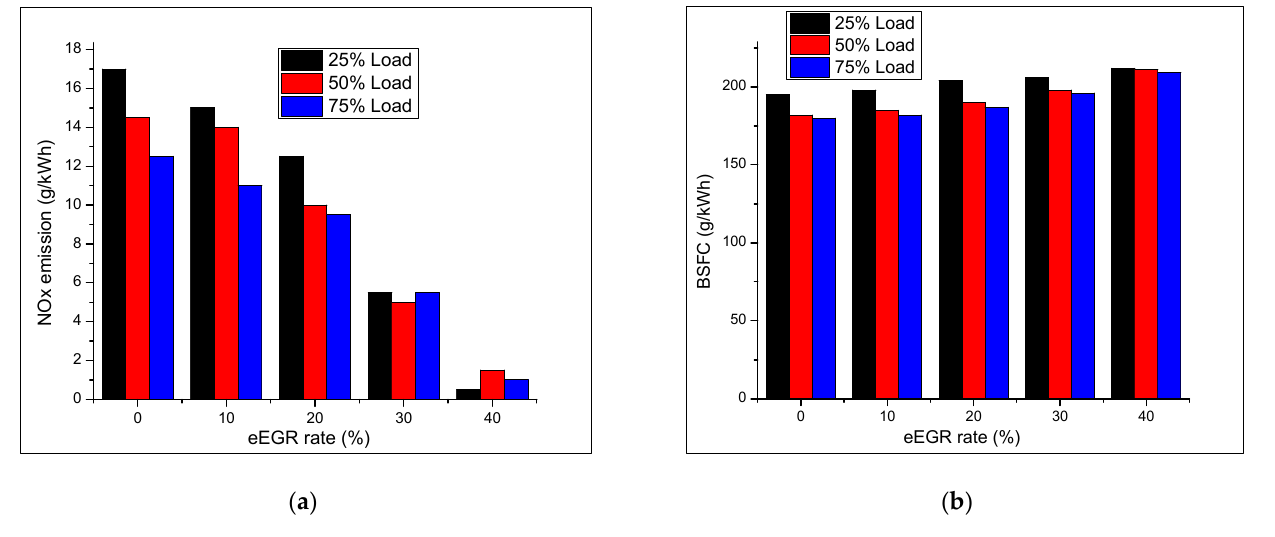
Figure 3. Effect of: ( a ) high-pressure eEGR on NO x emission; ( b ) high-pressure eEGR on BSFC